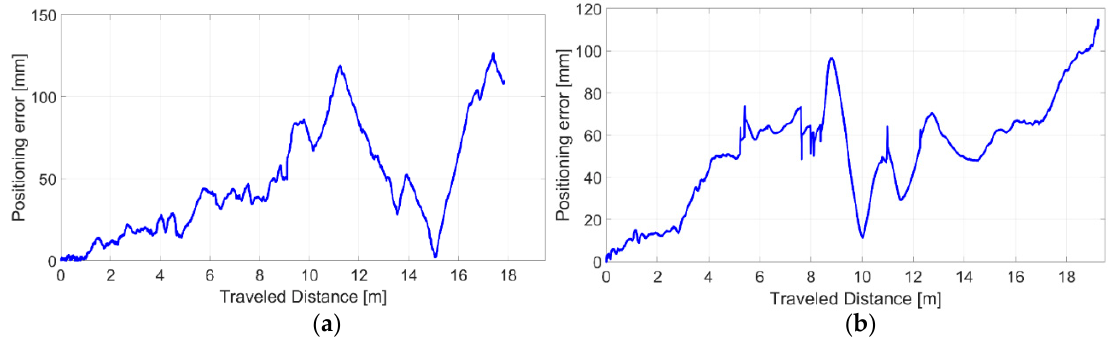
Figure 12. Drift positioning errors related to the first ( a ) and the second ( b ) experiment.